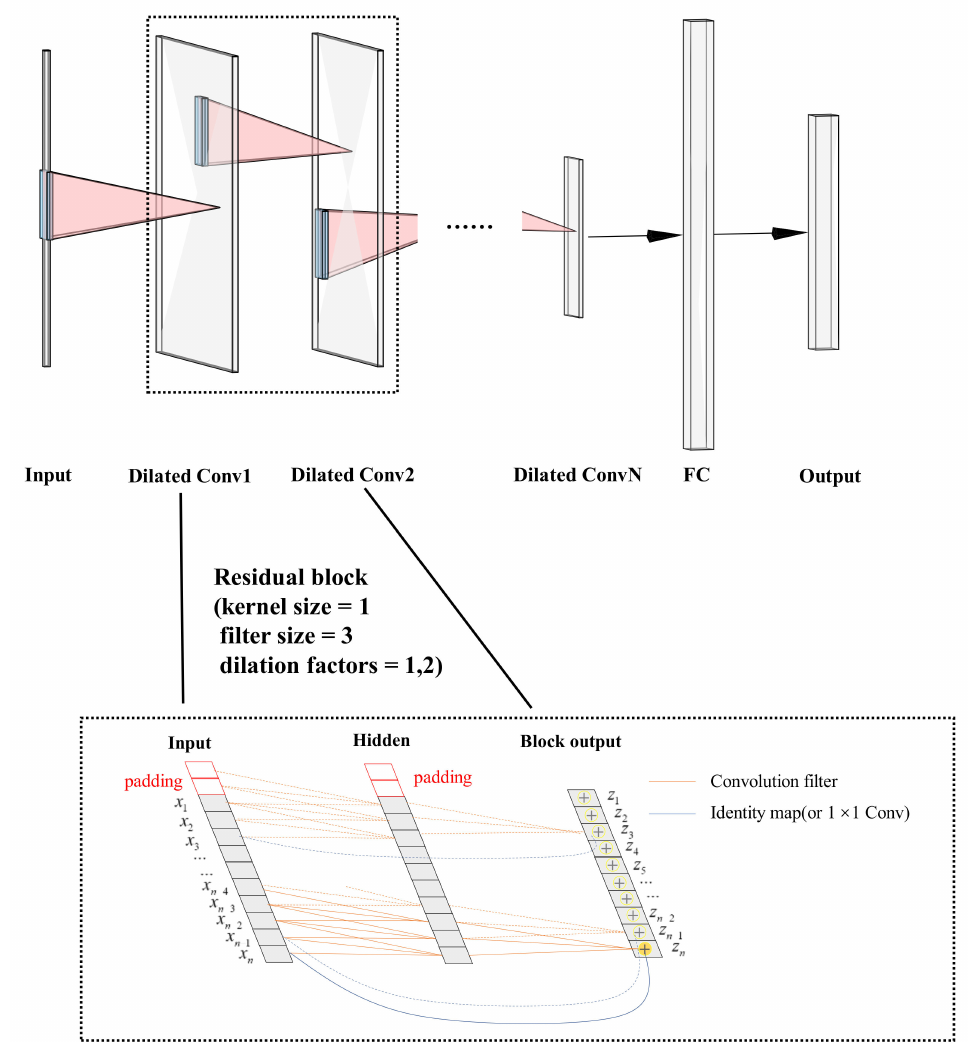
Figure 3. The system structure of the iHR estimation model using TCN in AlexNet style. Stack- ing residual blocks with dilation casual convolution layers using skip connection (simplified and visualized by the black dash boxed areas), a generic TCN model would be designed for sequence modeling. The bottom boxed areas show an example of a residual connection in a TCN. Two solid black lines indicate that the input of the Dilated Conv1 module in the top boxed area corresponds to the input layer in the bottom boxed area, and the input of Dilated Conv2 module in the top boxed area corresponds to the block output layer in the bottom boxed area. In this example, a dilated causal convolution with dilation factors d = 1,2 and filter size k = 3, the origin lines are filters in the residual function, and the blue lines are identity mappings. Across layers via identity mappings, skip connections effectively mitigate the gradient problem in deep models. To generate